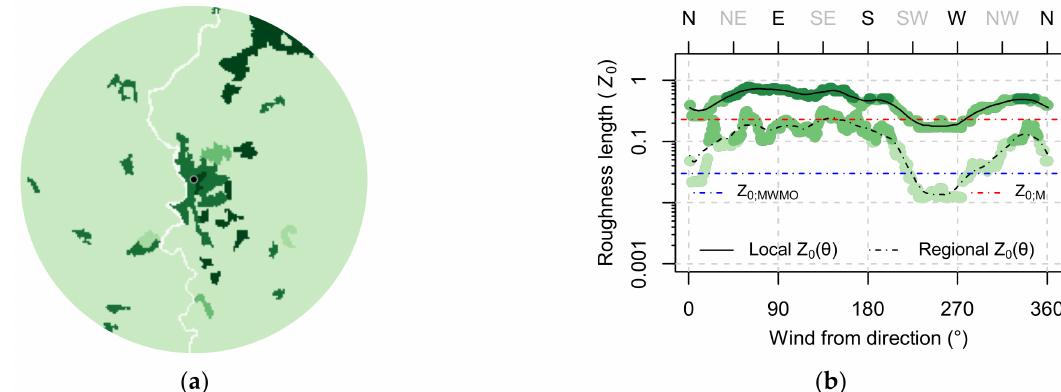
Figure 21. Derived surface roughness for GBORO site ( a ) in 10 km radius adapted from CLC map 2 ; ( b ) Directional local and regional surface roughness weighted by distance to building-site. Darker green colour indicates higher surface roughness values.